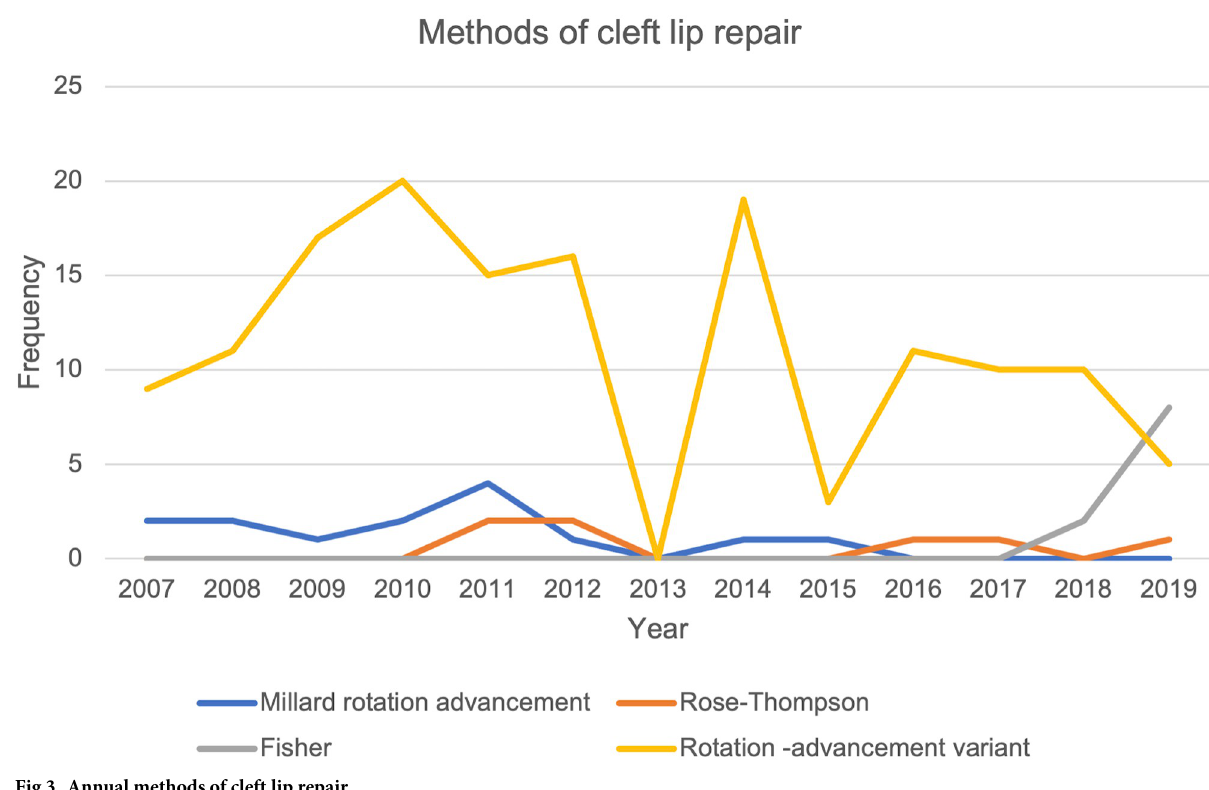
Fig 3. Annual methods of cleft lip